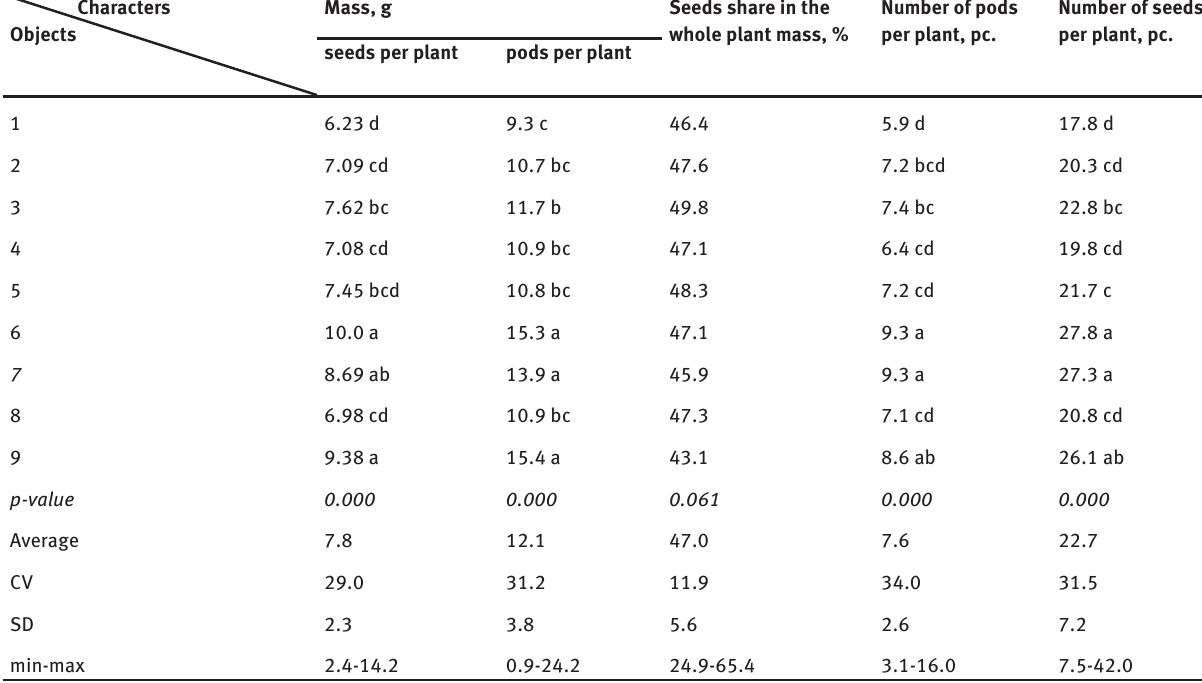
Table 3: Influence of vaccination treatment in white lupine seeds on the weight of seeds and pods per plant, seed share in the whole plant mass and the number of pods and seeds per plant. Characters Mass, g Seeds share in the Objects